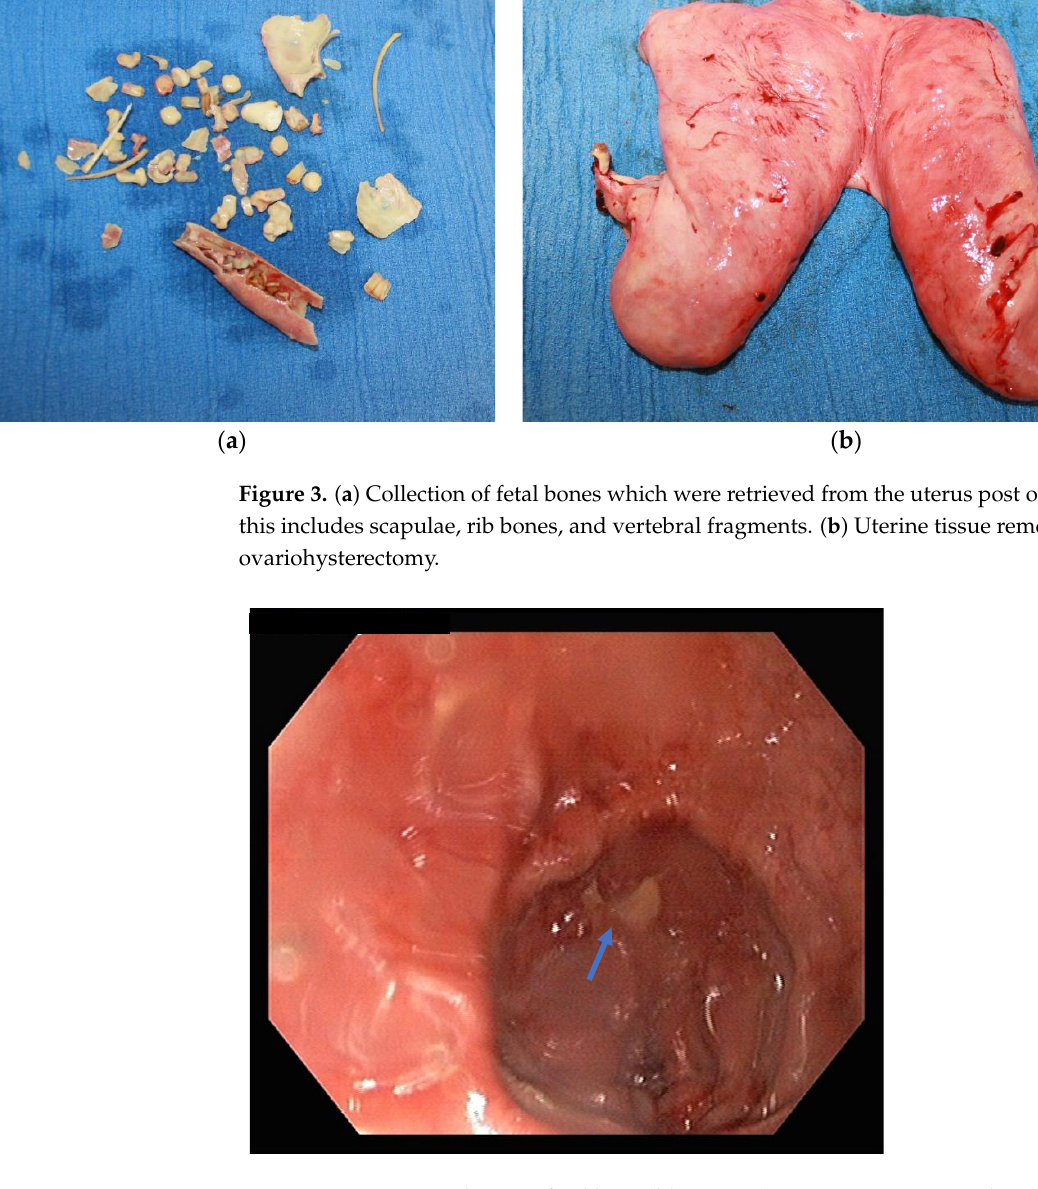
Figure 4. Uteroscopy showing fetal bone (blue arrow) remnant incorporated into the uterine stump closure post-ovariohysterectomy.